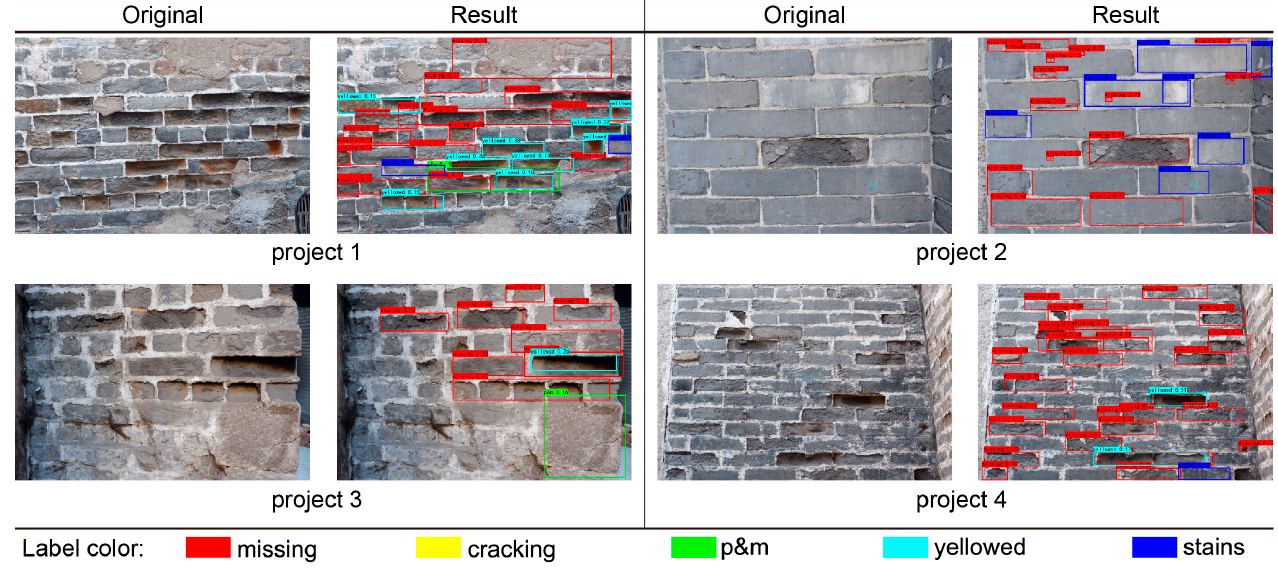
Figure 12. The detection effect of different construction project site photos. (Image Source: drawn by the author).